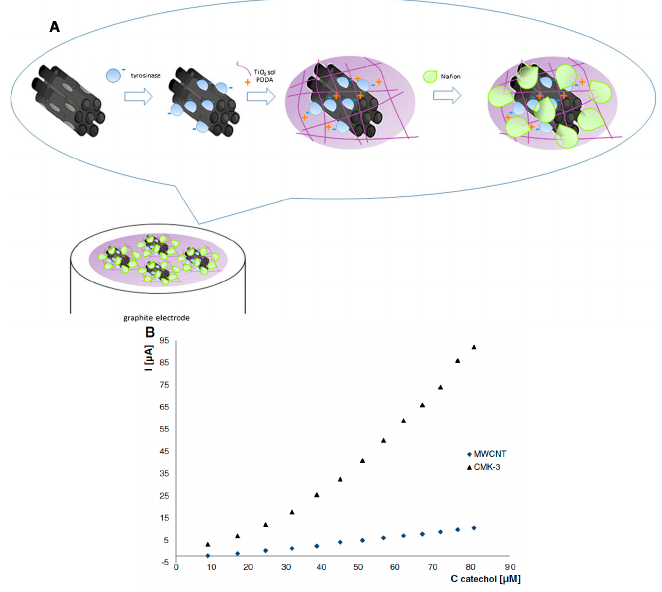
Figure 10. ( A ) Schematic illustration of a tyrosinase (TYR) OMC-based biosensor (TYR/TiO 2 /CMK-3/PDDA/Nafion, with PDDA = poly(diallyl-dimethyl-ammonium chloride)). ( B ) Corresponding calibration curve for catechol and comparison to a similar system based on carbon nanotubes (reproduced from [246]).